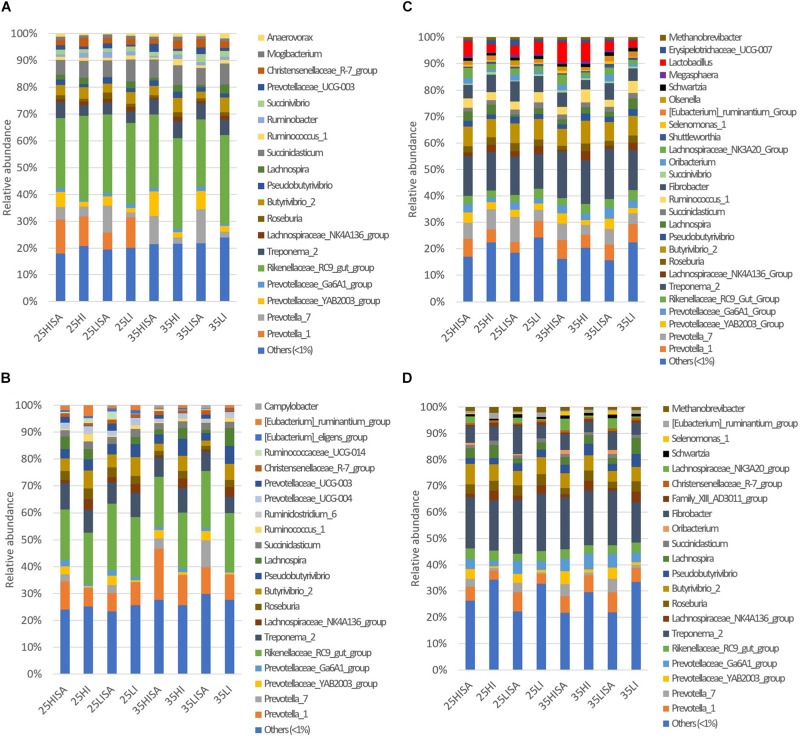
Relative abundances of major prokaryotic genera (>1% relative abundance in at least one alfalfa silage type) and others (<1% relative abundance) in samples for (A) liquid phase at the early time point; (B) liquid phase at the late time point; (C) solid phase at the early time point; (D) solid phase at the late time point. Bars represent means (n = 4) for each alfalfa silage (AS) type. Abbreviations for each AS type indicate the pre-ensiling treatments including different dry matter concentrations (25 or 35), wilting intensities [low (LI) or high (HI)] and sucrose addition (SA).